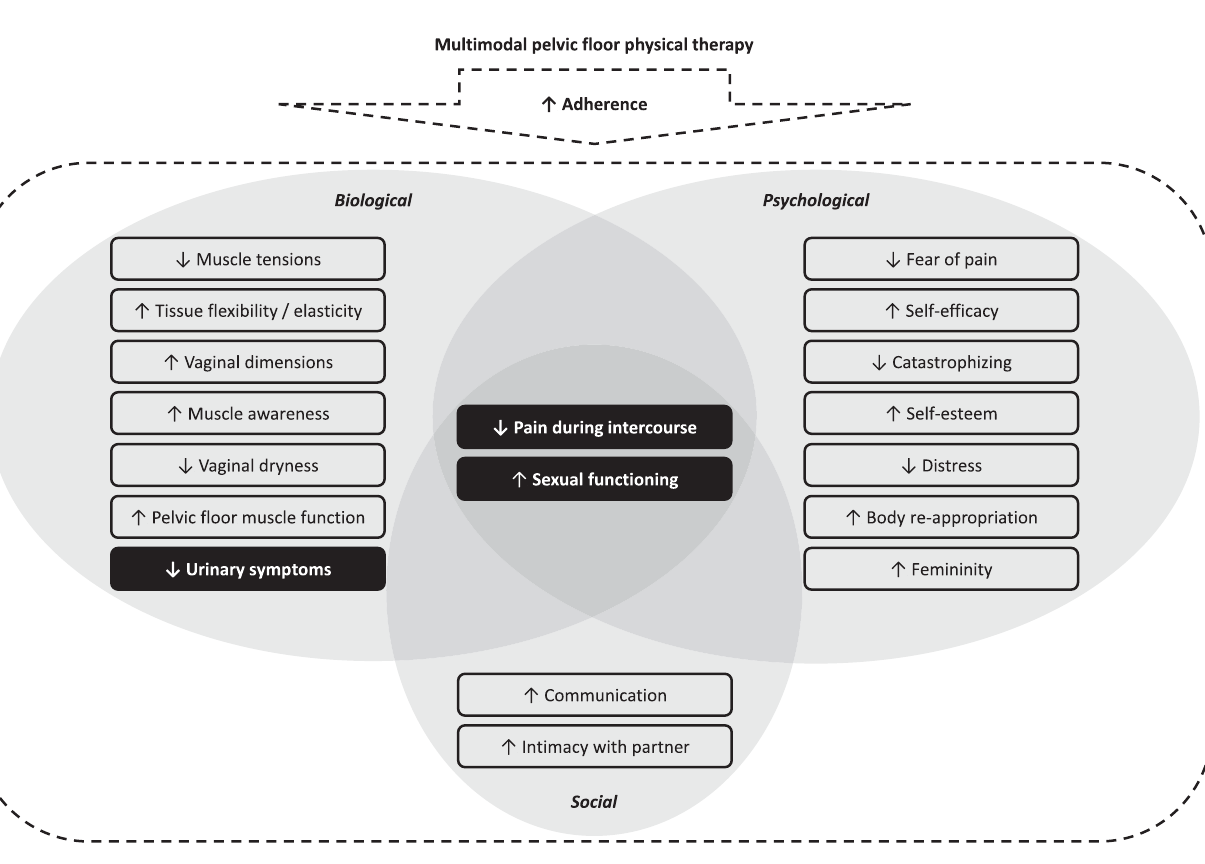
Fig 2. Relationships between treatment effects that emerged from the